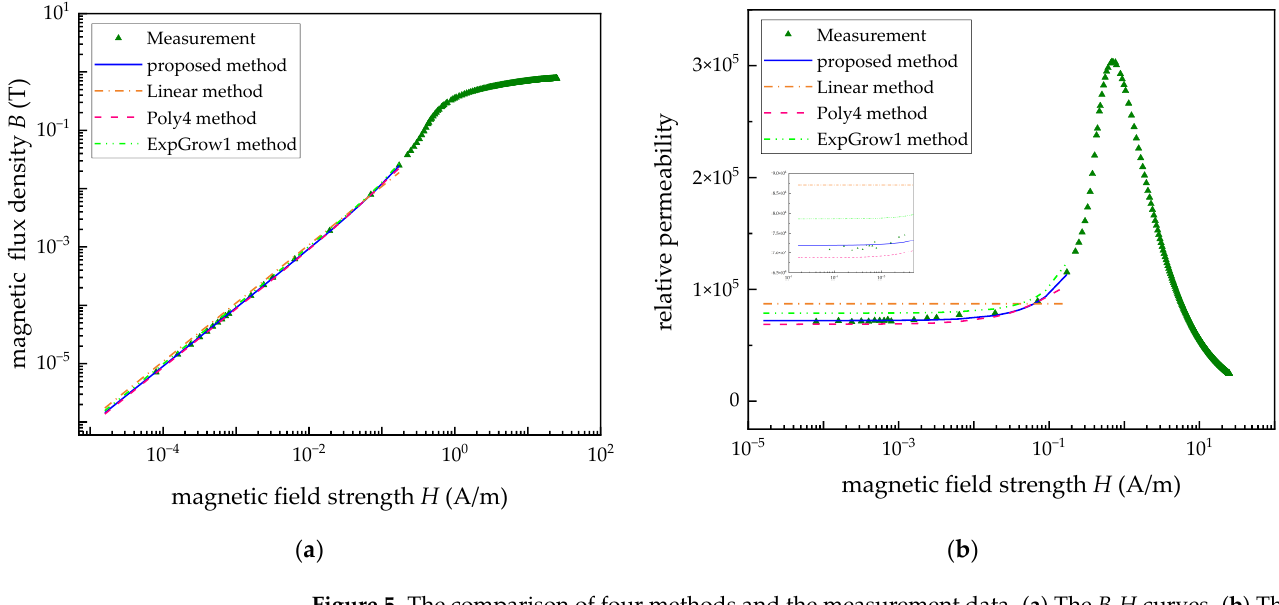
Figure 5. The comparison of four methods and the measurement data. ( a ) The B - H curves. ( b ) The relative permeability curves.